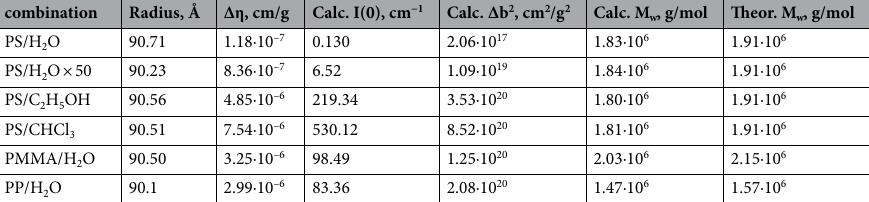
Table 2. Parameters, obtained by fitting procedure and the method